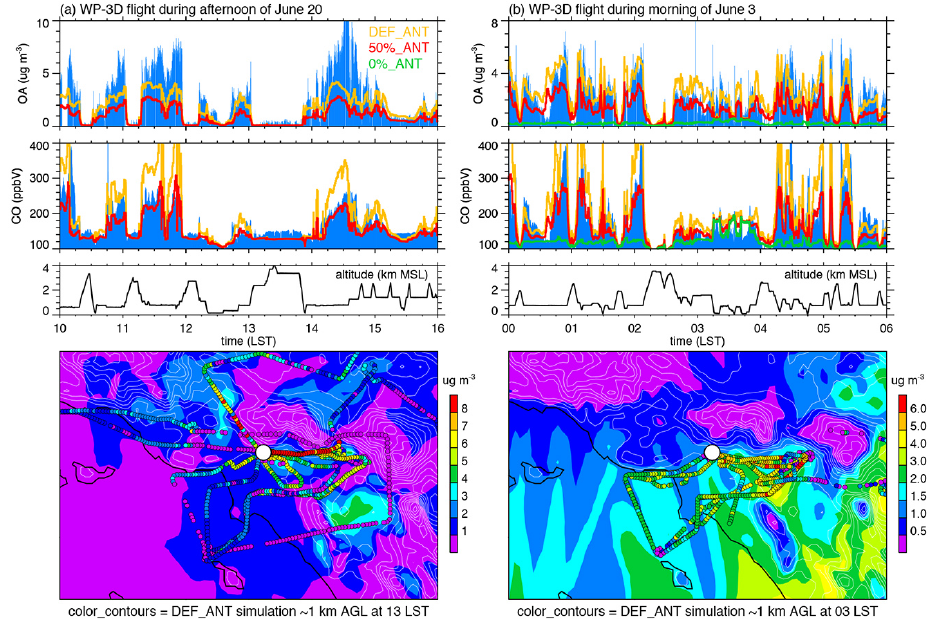
Figure 15. Observed and simulated OA during CalNex in the vicinity of Los Angeles during (a) the afternoon of 20 June and (b) the morning of 3 June. (a) and (b) represent days with high and low observed OA, respectively. The white dot denotes the location of the Pasadena supersite. Simulated OA is the total of the first four model size bins up to 0.625µm